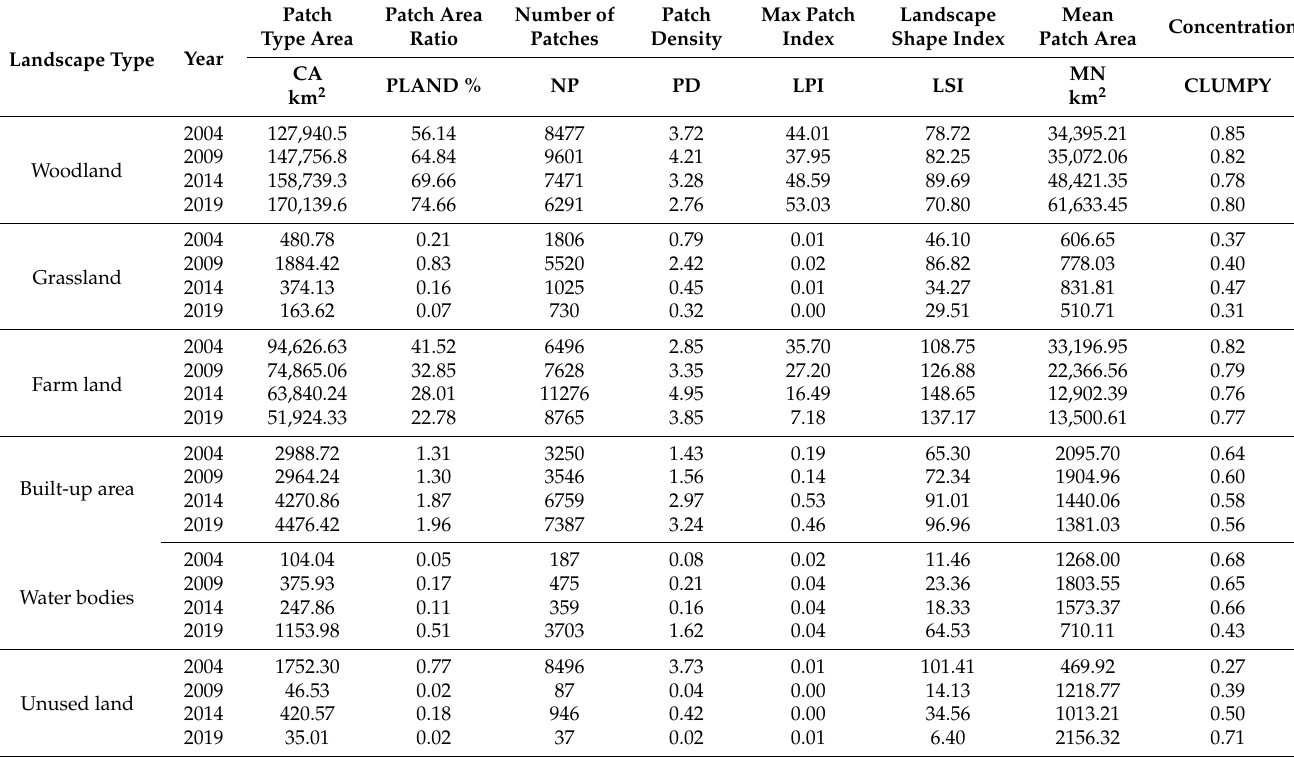
When the analysis was expanded for the different categories of land use (i.e., wood- land, farmland, built-up area, water, grassland, and unused land), the results showed an overall improvement for unused land, woodland, and grassland, while built-up area and farmland decreased their spatial representation. Indeed, the overall farmland for agricul- ture and unused land decreased, while woodland, grass and built-up area increased. The patch area ratio also followed a similar trend. In the half of the first decade (2004–2009), the landscape shape index declined for woodland (3.7%) and farmland (3.5%), while stabilized in the following years. Landscape shape index did not change for grassland during all the 15 years assessed, showing an increase for built-up area and a decrease for unused land, despite slight stabilization between 2004 and 2009 (Table 8). Table 8. Change on LULC in Long County during the 15 years (2004–2019), based on different landscape metrics.